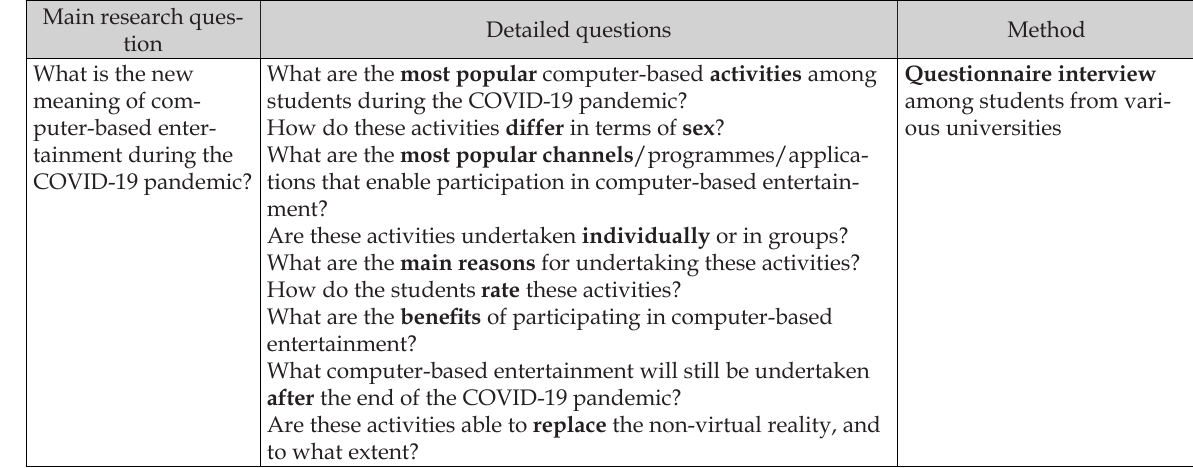
Table 1. Selected methodology of the